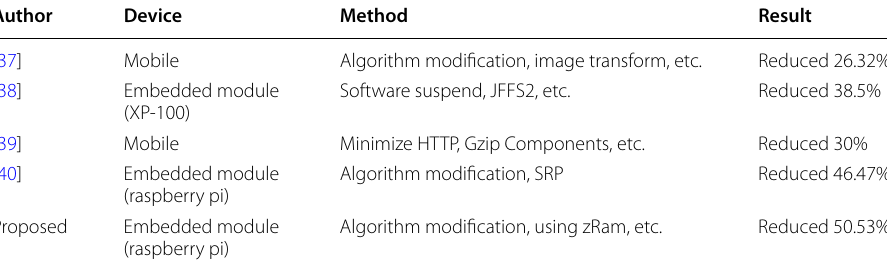
Table 8 Comparison of processing time before and after optimization